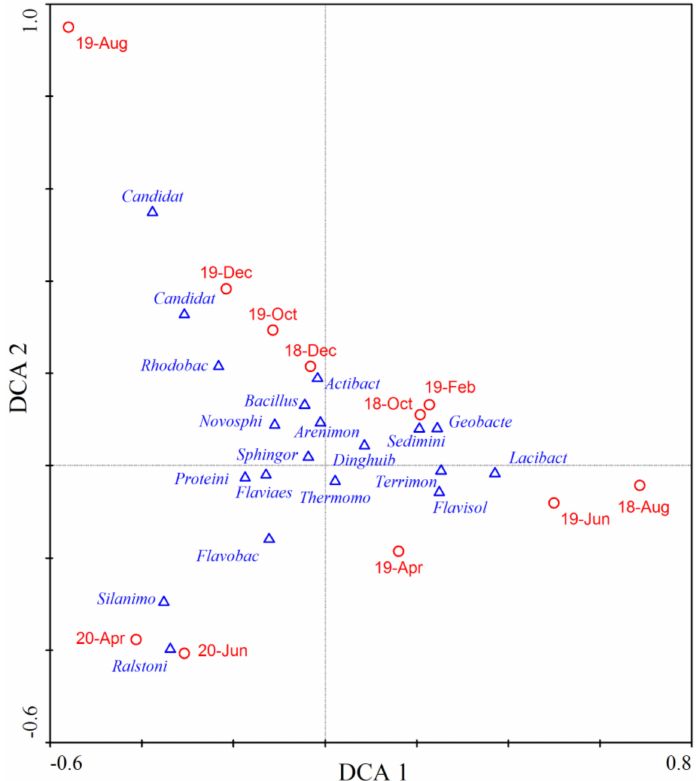
Figure 6. DCA plots showing the average similarity of sediment microbial community between different measurements. Blue triangles stand for dominant genera in the river and red circles for community at different months. The names in the figure are the abbreviation of microbial genera listed in Figure